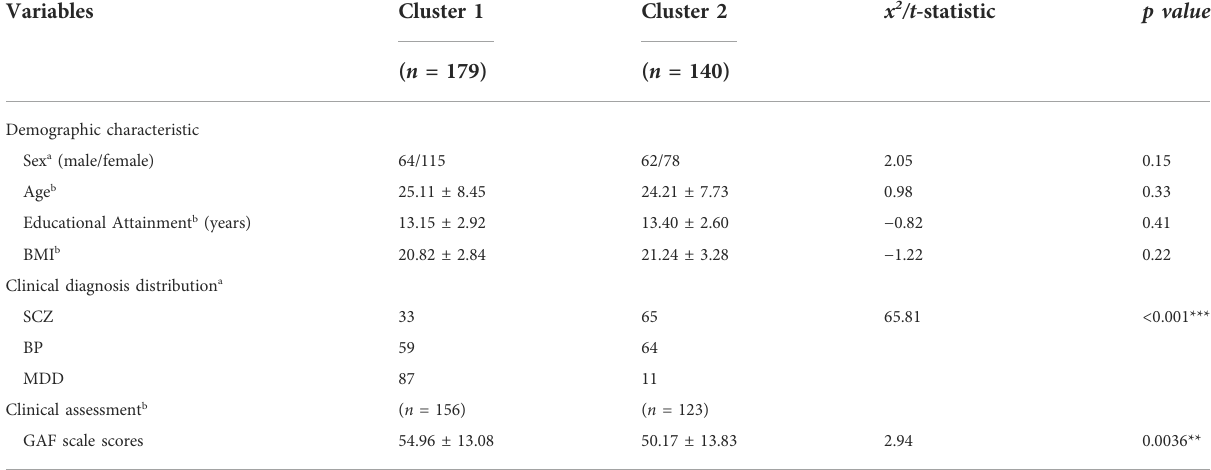
TABLE 3 Comparison of demographic characteristics and functional impairment assessment between the lipid-based subgroups.